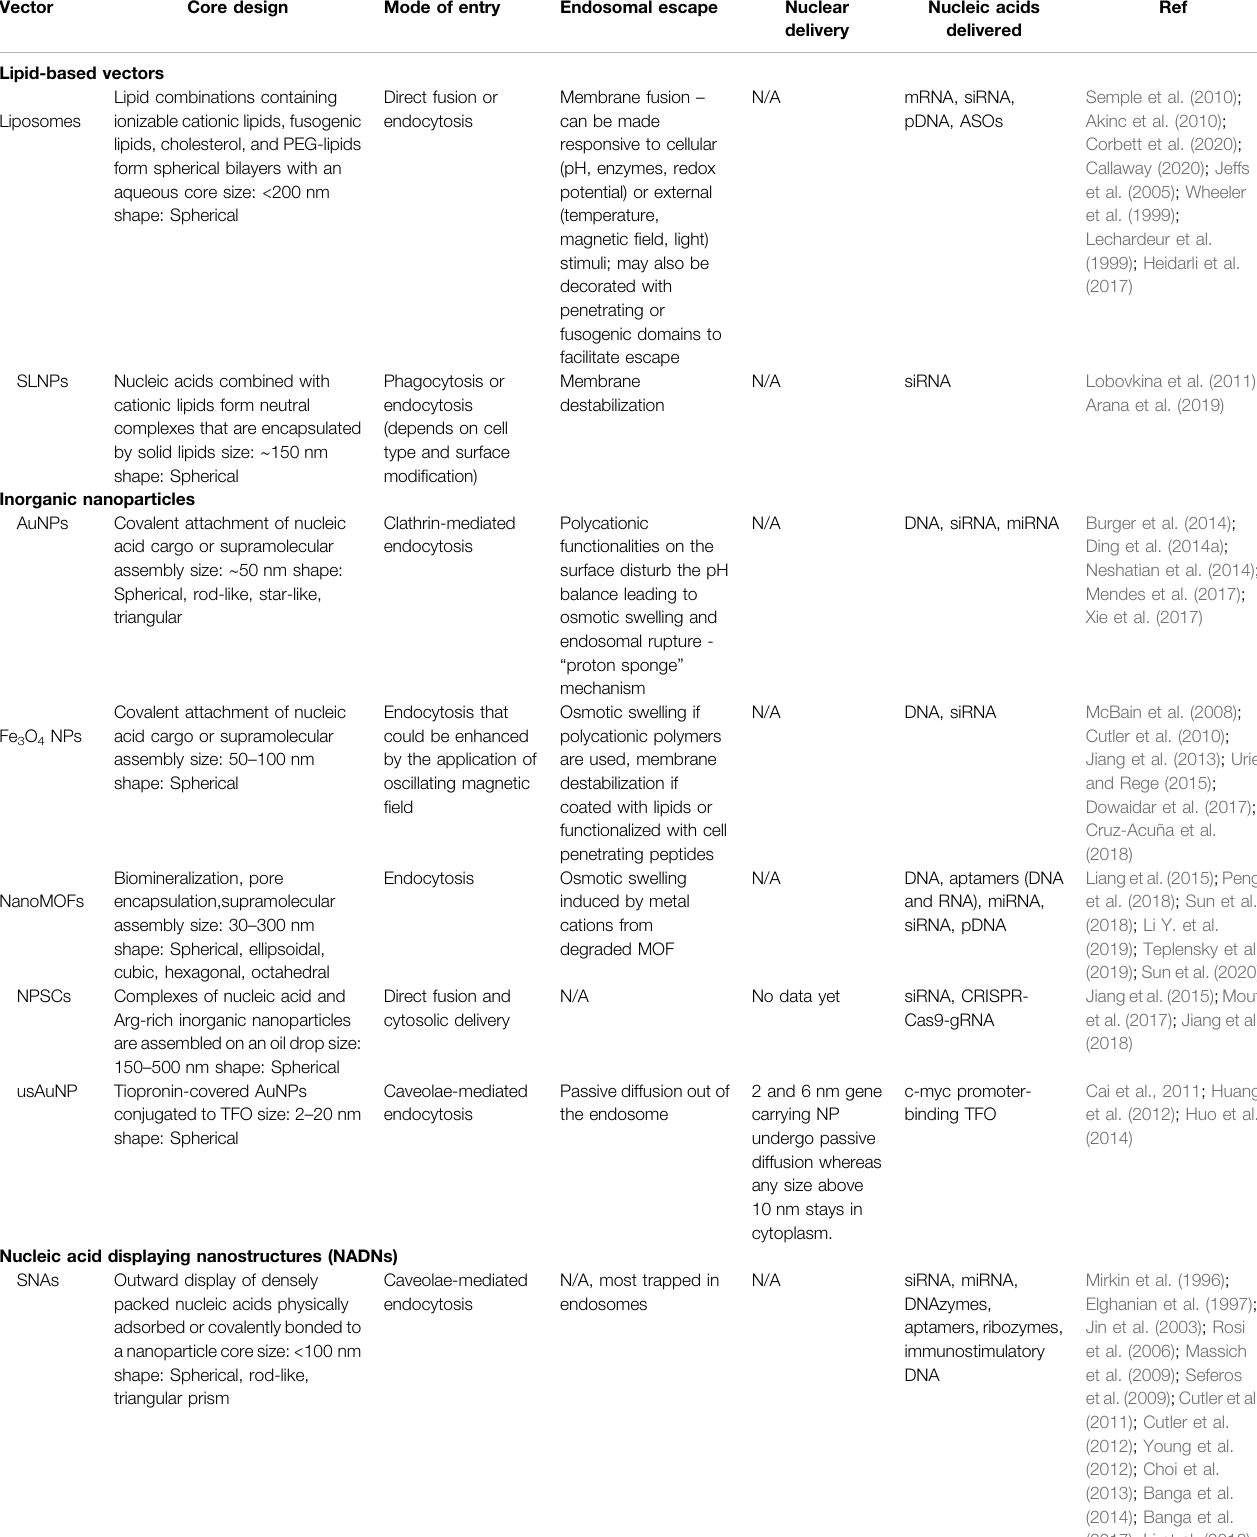
TABLE 1 | ( Continued ) Nucleic acid carriers: Properties and traf fi